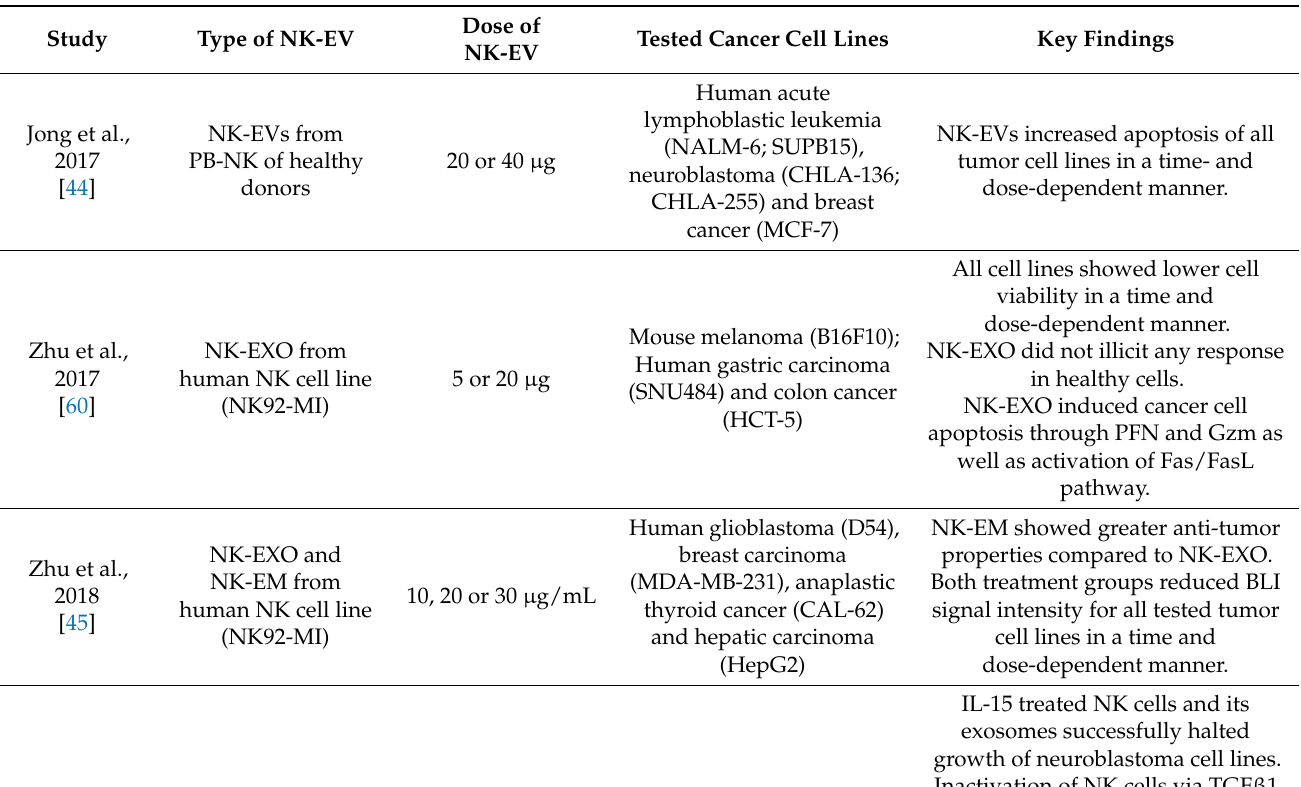
Table 1. In vitro evidence demonstrating cytotoxicity of NK-EVs against various cancer cell